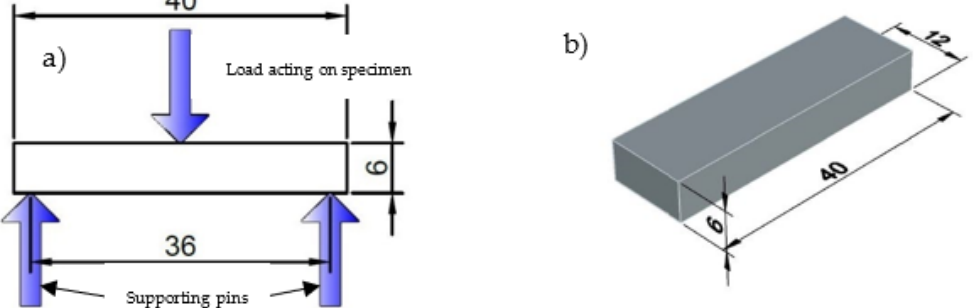
Figure 3. ( a ) Experimental setup of ILSS test. ( b ) Isometric view of ILSS specimen.